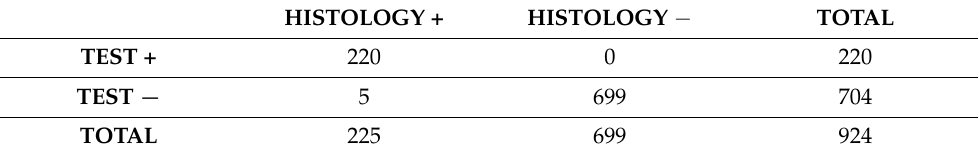
Table 2. The results of the iNatal duo test not taking PPI compared with histology.